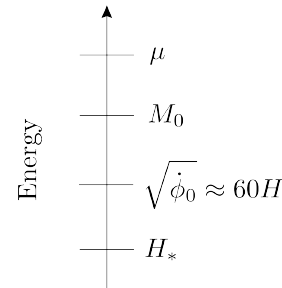
Figure 1 . A summary of relevant mass scales considered in this work. At a typical point on the inflationary trajectory, the heavy field mass is ∼ µ (cid:29) p ˙ φ However, the mass passes through a minimum M η ∗ and non-negligible particle production takes place for M 0 &